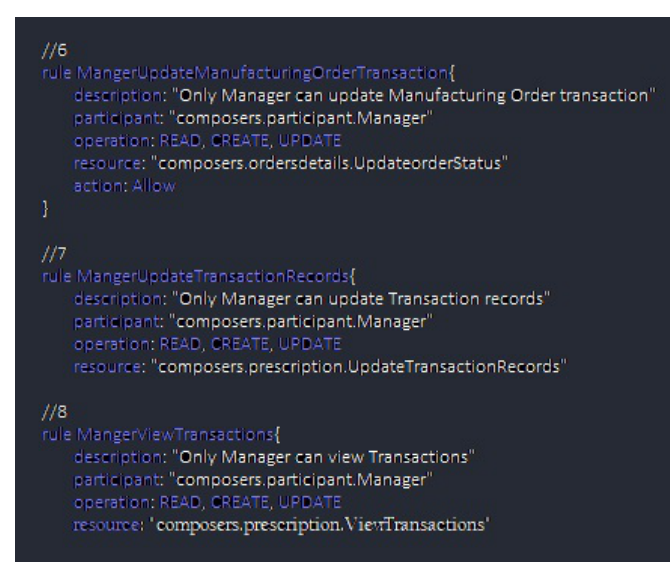
Figure 6. Access control definition in the proposed manufacturing system.